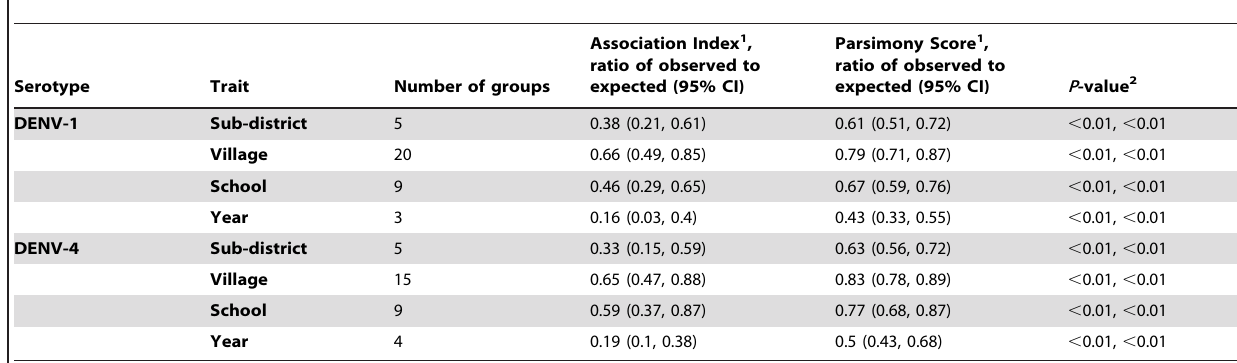
Table 4. Phylogeny-trait association tests of phylogenetic structure of geographic and temporal traits of DENV-1 and DENV-4.